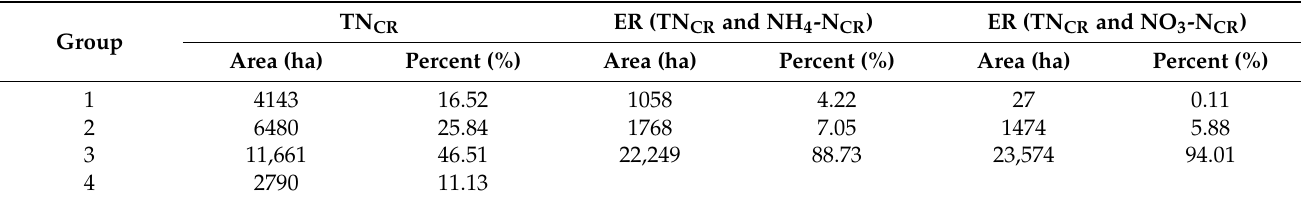
Table 6. Areas of four groups for TN CR and the different significant areas of ERs between TN CR and NH 4 -N CR , and the ERs between TN CR and NO 3 -N CR in the Sanhuanpao wetland.